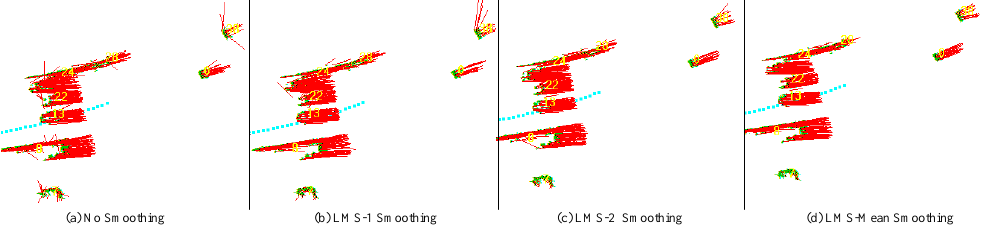
Figure 9. Comparison of various smoothing algorithms. ( a ) The raw motion field without spatial smoothing. Furthermore, comparing ( b ) and ( c ), we found that the performance of LMS-2 smoothing is better than that of LMS-1 smoothing. Obviously, the motion field smoothed by LMS mean smoothing ( d ) is the optimum one with the best spatial